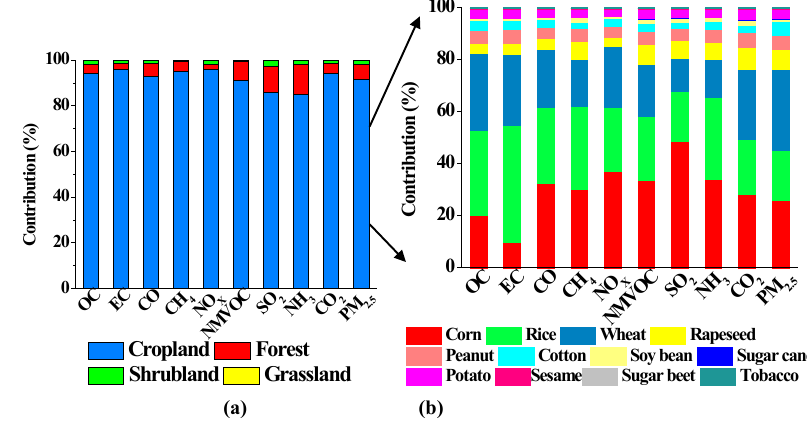
Figure 2. The mean contributions of different types of biomass to biomass burning pollutant emission (a) and the mean contributions of different types of crops to cropland accumulative pollutant emission (b) from 2003 to